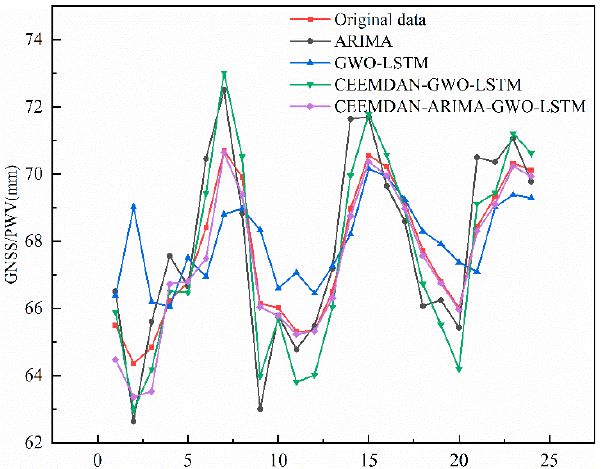
Figure 12. Comparison of the prediction results for various models. Table 3. Model error values of each site.